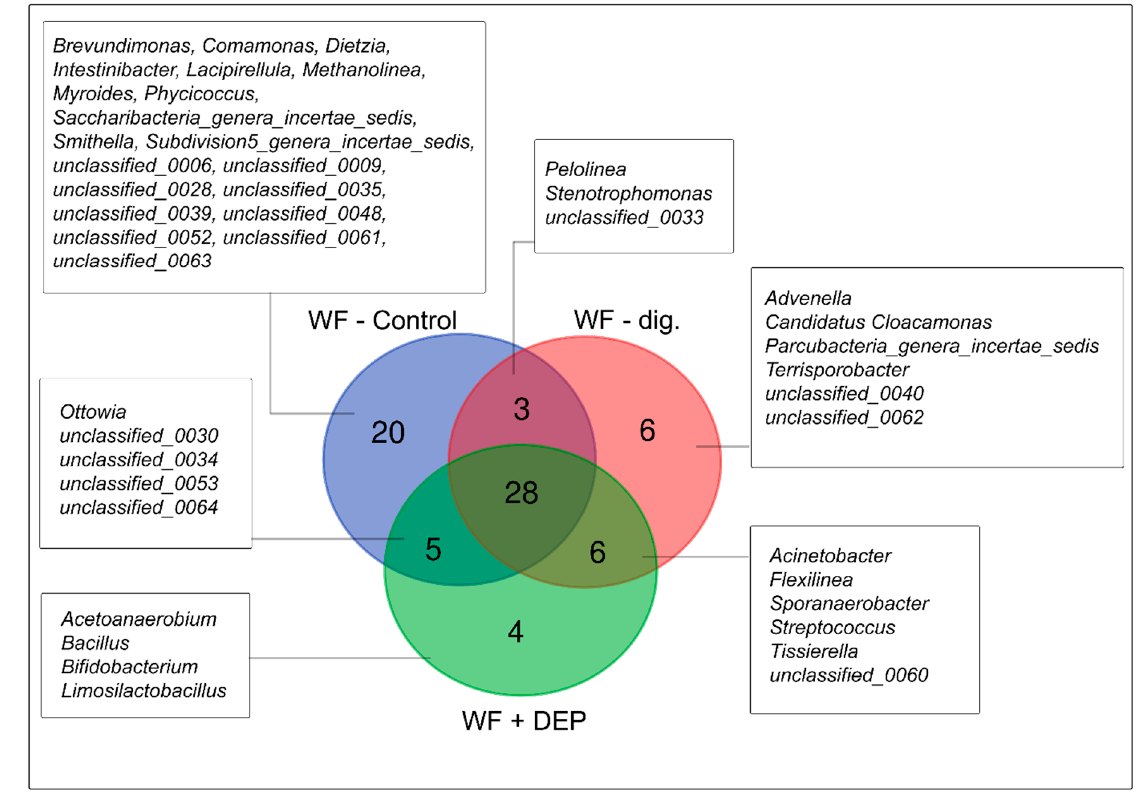
Figure 5. Venn diagram of overlapping bacterial communities from the three variants.